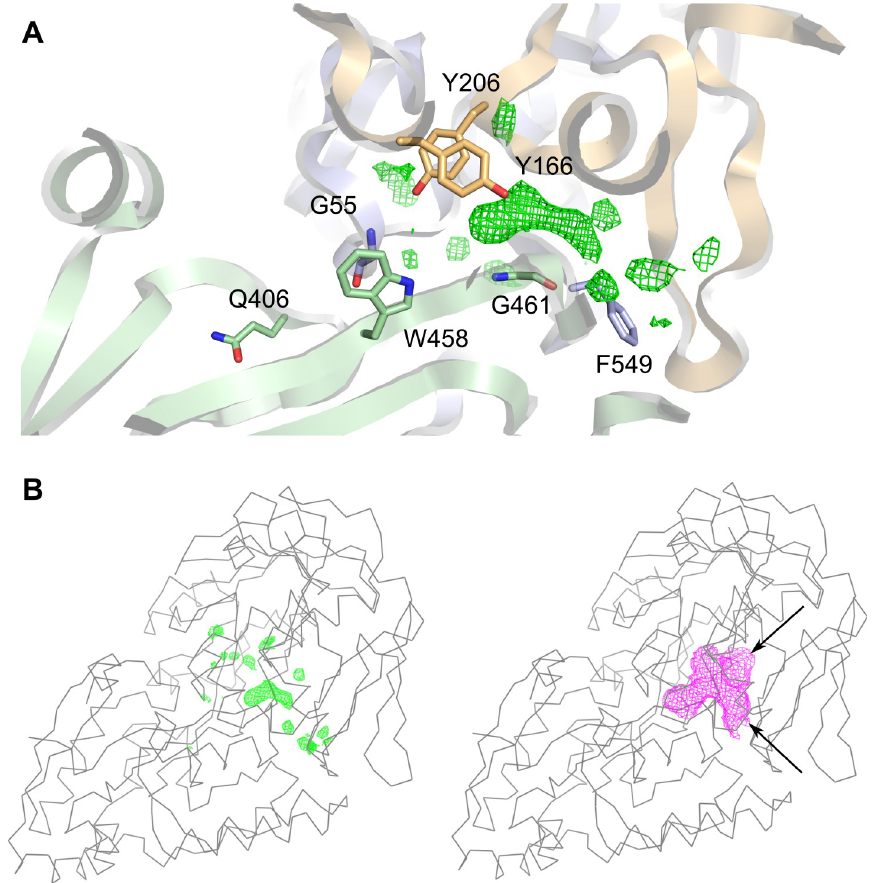
Fig 3. The SapA ligand-binding cavity. A, a detailed view of the SapA closed ligand binding cavity. Aromatic residues lining the cavity are shown in stick representation together with the other residues discussed in the text. Unexplained Fo-Fc residual density is represented as a green mesh and is contoured at 3 σ . B, left: The same Fo-Fc density highlighted in the context of the overall view of SapA closed (c α trace). Right: The ligand-binding cavity of SapA closed as calculated by the program Voidoo (magenta mesh). Arrows indicate cavity openings to the protein